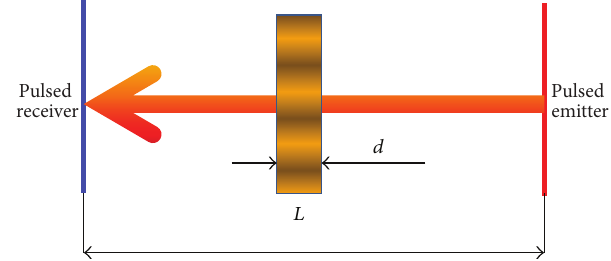
Figure 4: Diagram showing the geometry of the through-trans- mission